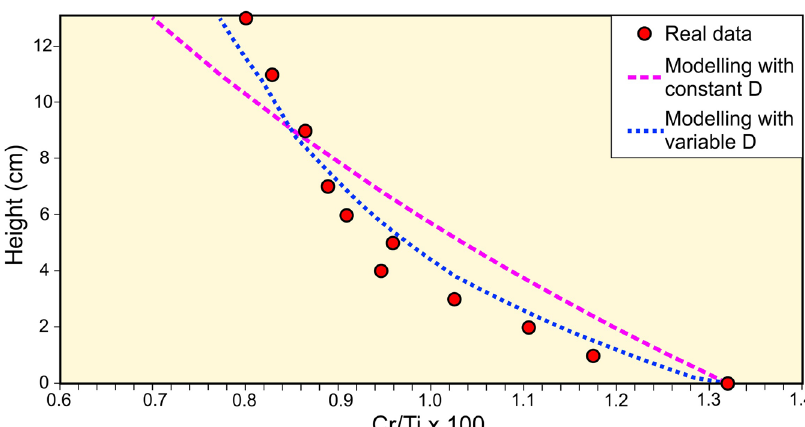
Fig. 6 Geochemical modeling assuming Rayleigh-style fractionation of the variation in Cr across the upper gradational contact shown in Fig. 5c. Using a constant bulk D value for Cr of 30 (assuming a value of 300 in magnetite and a cotectic proportion of 10% of magnetite to plagioclase), a relatively poor match is obtained between the modeling and real chemical data. If the bulk D value is assumed to decrease (from to 284 to 89) in line with the increase in the modal abundance of plagioclase (from about 5 – 70%) observed upwards in the contact, a much better fi t with the data can be